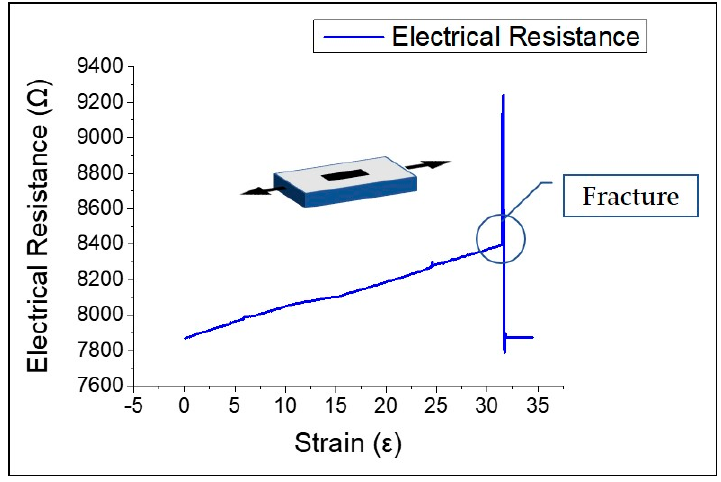
Figure 10. Change in electrical resistance corresponding to strain and fracture. Figure 8. Response of LIG strain sensor under stretch/release cycle of ( a ) ε = 1%; ( b ) ε = 3% and 7%. Cyclic tensile testing was applied to the strain sensor; we evaluated the piezoresistive e ff ect